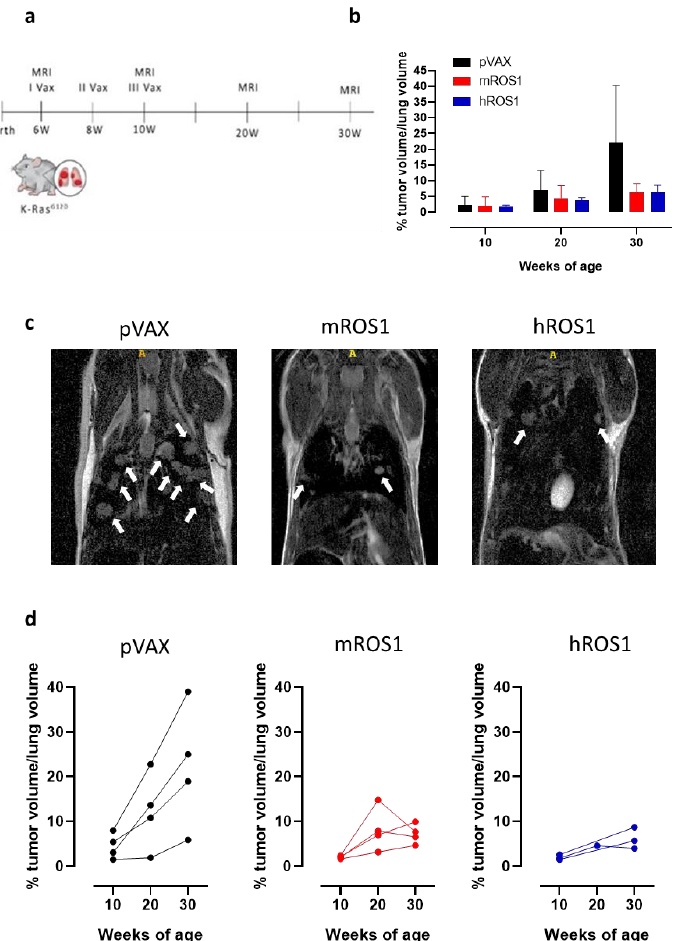
Figure 7. Impact of anti-ROS1 DNA vaccination on the autochthonous lung carcinogenesis of K-Ras G12D mice. ( a ) Protocol timeline for DNA electrovaccination. ( b ) Percentage (mean ± SD) of tumor volume occupying the lungs in 10, 20, and 30-week-old pVAX (black bars), mROS1 (red bars), and hROS1 (blue bars) electrovaccinated K-Ras G12D mice (N = 4–12). ( c ) Representative MRI images of 30-week-old K-Ras G12D mice immunized with pVAX (left panel), mROS1 (middle panel), and hROS1 (right panel) acquired with a 7T high field scanner (N = 3 mice for each time point). White hyperintense regions indicated by arrows are tumors. ( d ) Tumor progression of pVAX- (black bars; N = 4 mice), mROS1- (red bars; N = 4 mice), and hROS1- (blue bars; N = 3 mice) electrovaccinated K-Ras G12D mice over time. Each single mouse was imaged by MRI at 10, 20, and 30 weeks of age. Data are shown as percentage of tumor volume occupying the lungs of each single